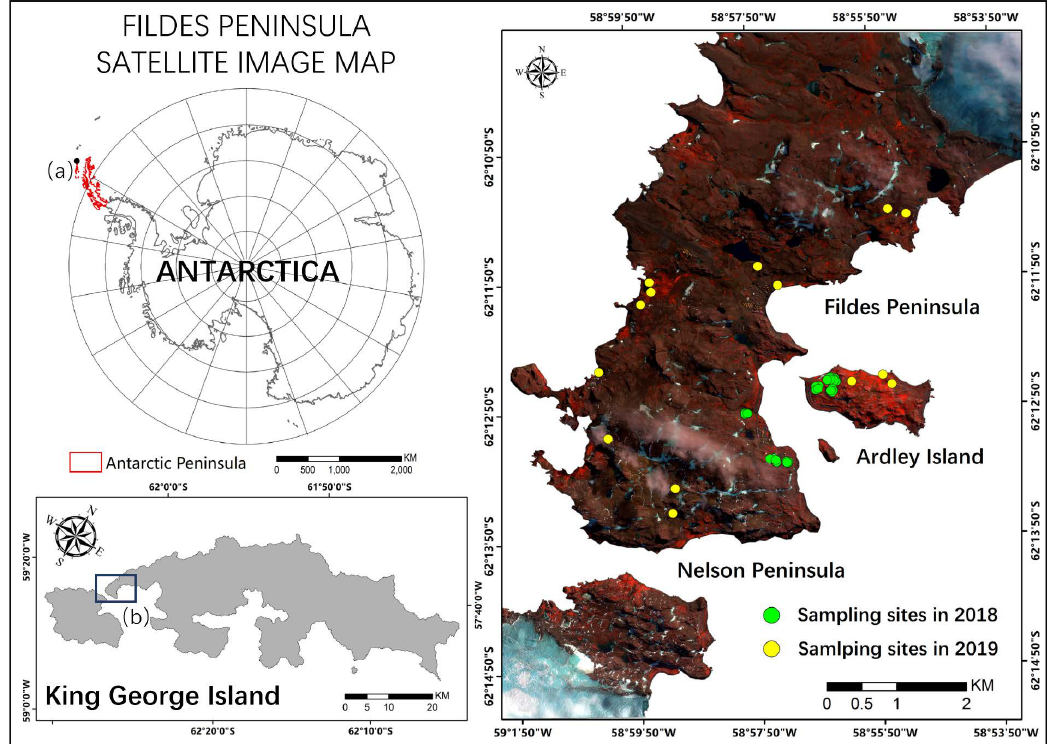
Figure 1. Study area and field measurement sites. The image is color-coded with red: band 8, green: band 4, and blue: band 1 of the WorldView-2 (WV-2) satellite image acquired on 23 March 2018.( a ) King George Island ( b ) Fildes Peninsula, Ardley Island and a part of the Nelson